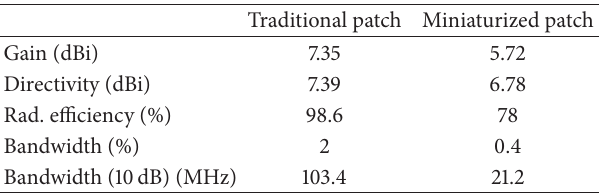
Figure 13: Transmission line loaded with CSRR. Table 2: Comparison of performances of the traditional and miniaturized patch antennas obtained through